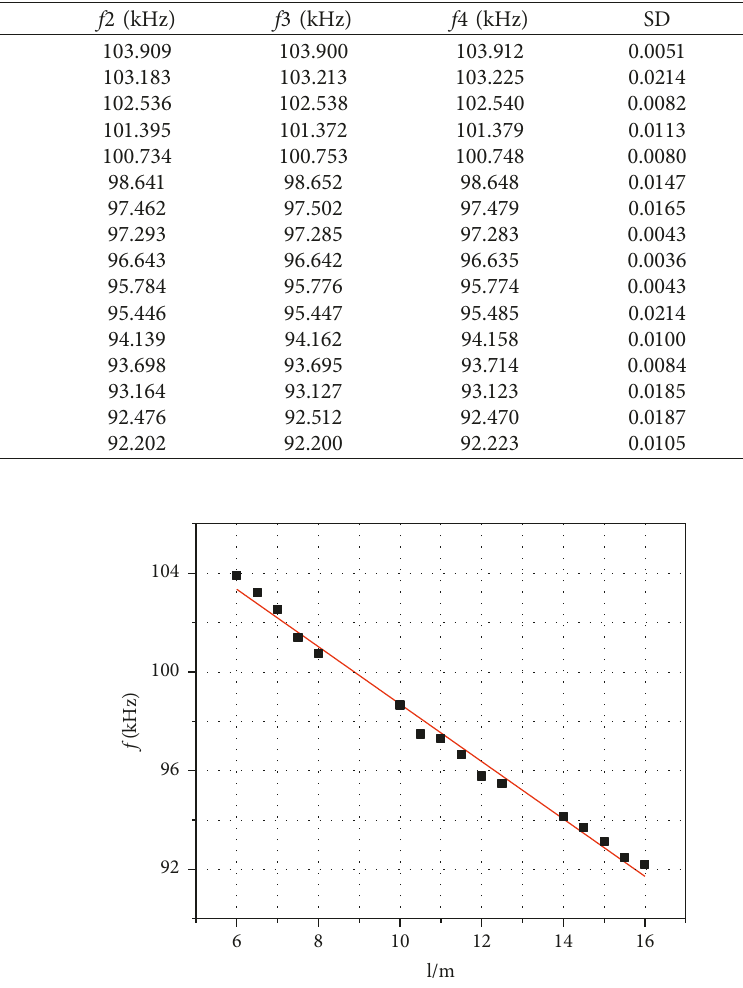
Figure 11: l- f analysis diagram of steel strands.